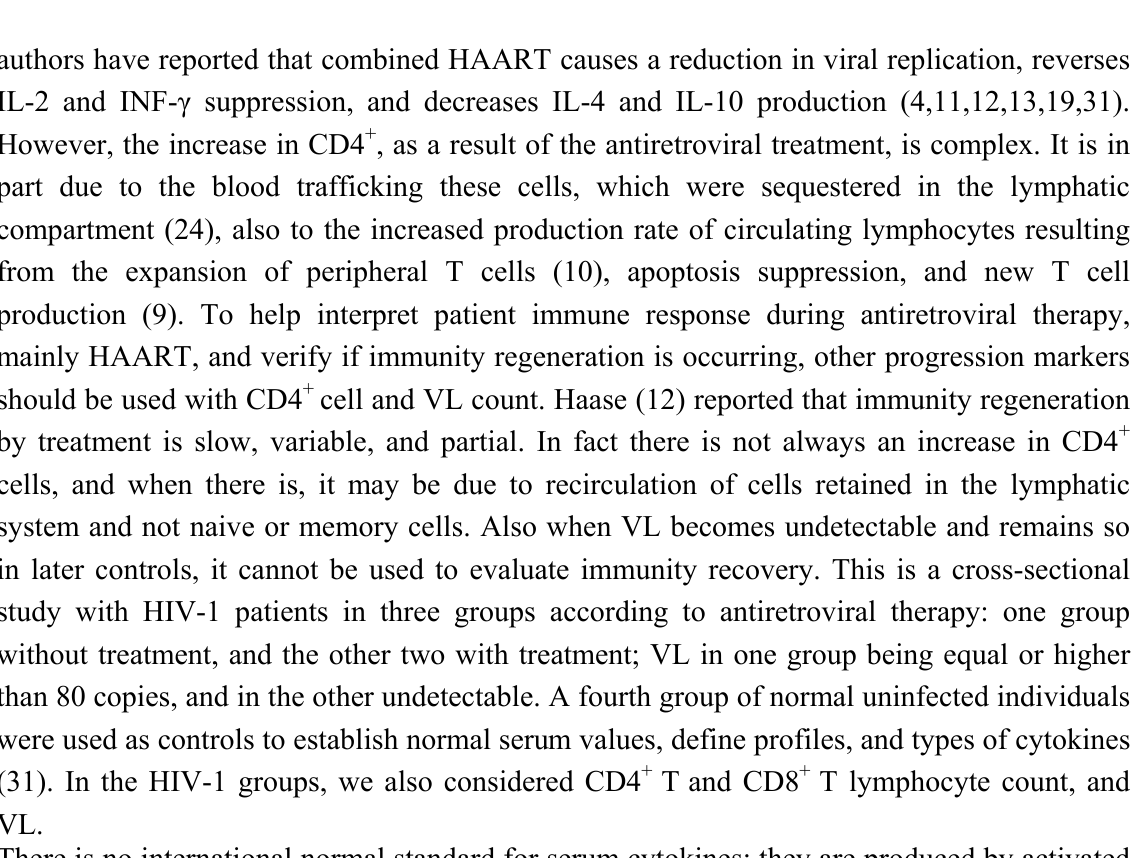
D. A. Meira et al . CORRELATION BETWEEN CYTOKINE SERUM LEVELS, NUMBER OF CD4 + T CELLS/mm³ AND VIRAL LOAD IN HIV-1 INFECTED INDIVIDUALS WITH OR WITHOUT ANTIRETROVIRAL THERAPY.